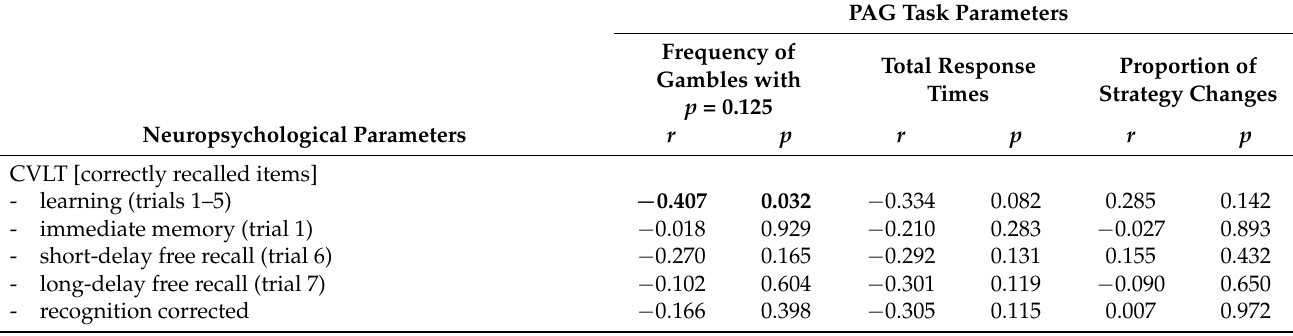
Table 4. Pearson’s correlations between decision making performance and neuropsychological background scores in patients with schizophrenia (n =